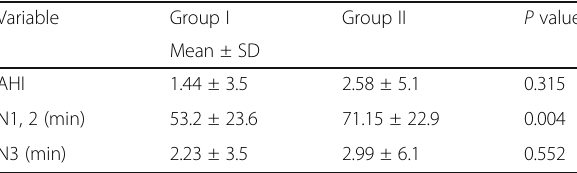
Table 3 Comparison between both groups regarding sleep architecture and breathing events